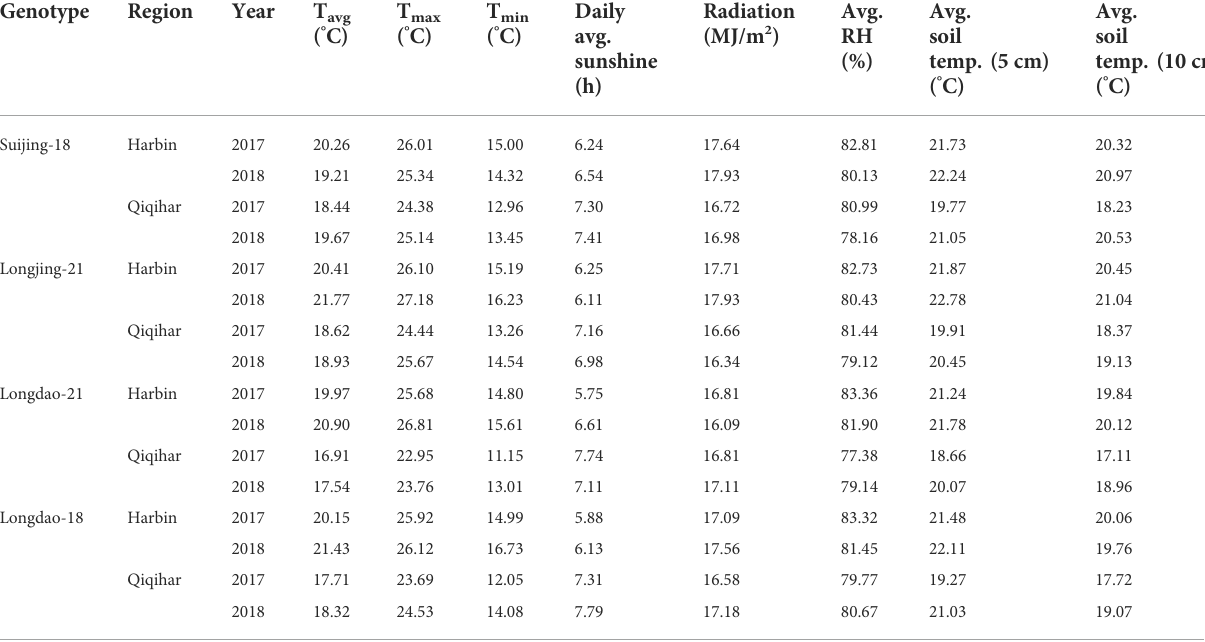
TABLE 4 Comparison of variations in the prevalence of environmental conditions at the grain- fi lling stage of Japonica rice in Harbin and Qiqihar, 2017 and 2018. Genotype